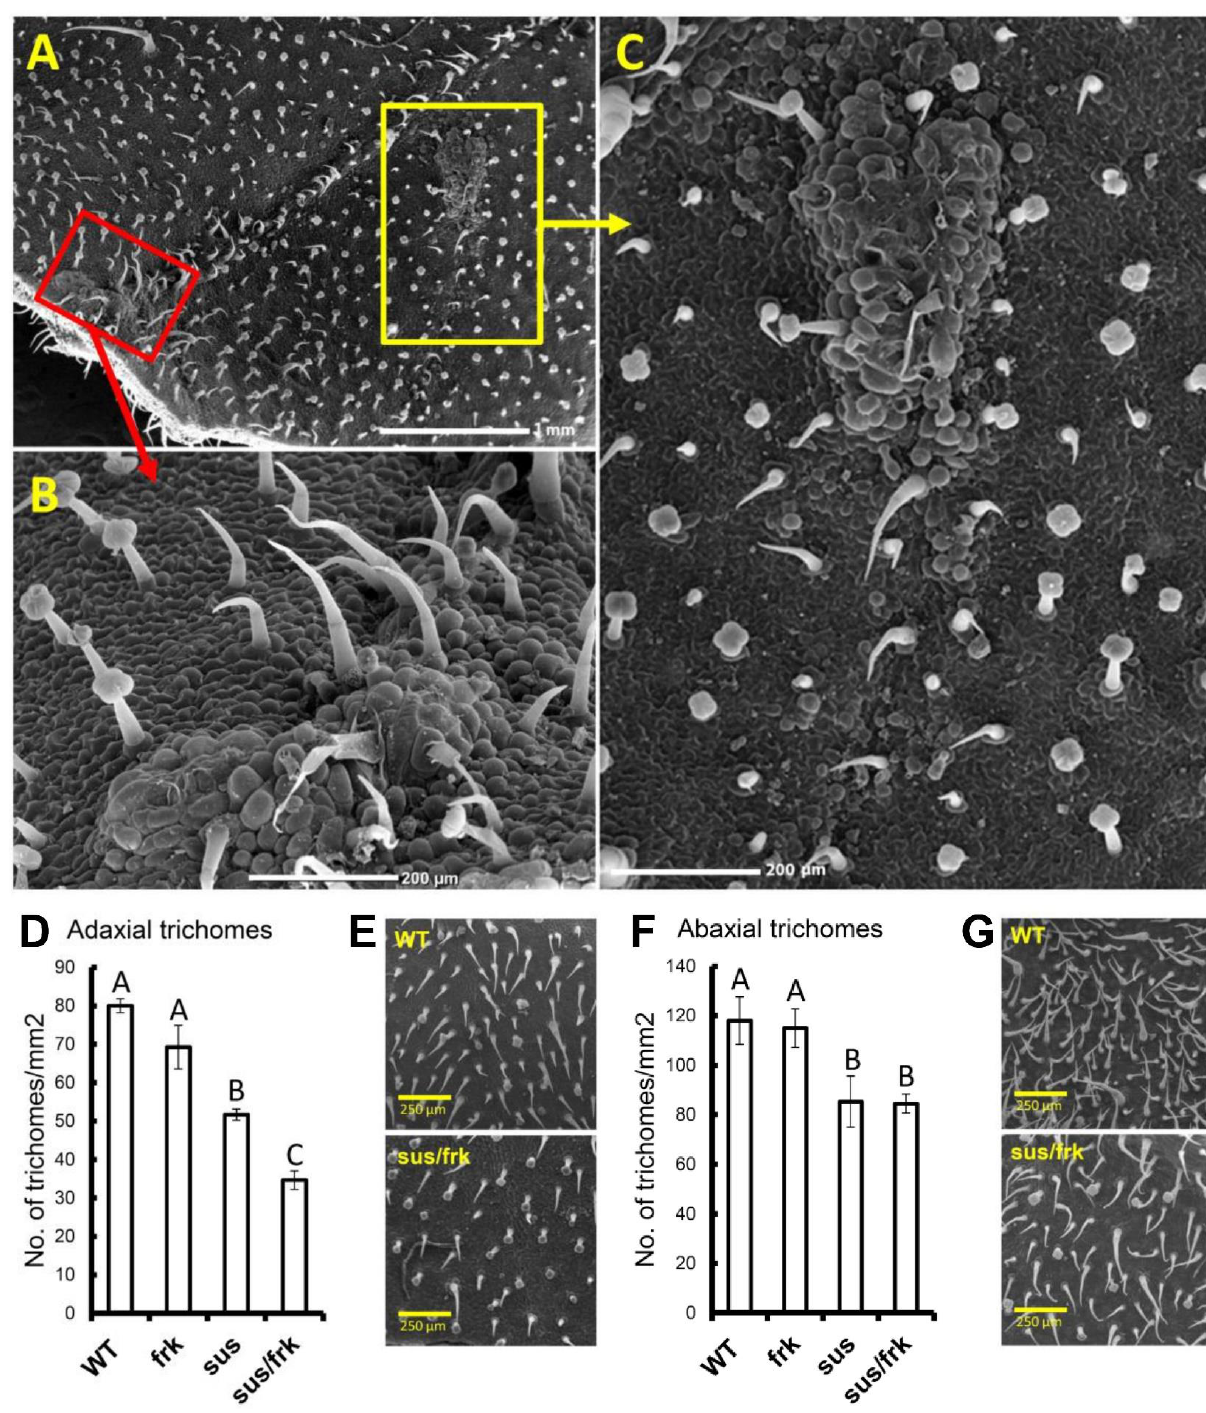
Figure 6. Formation of callus tissue on the adaxial blade of a sus / frk leaf and the sus / frk leaves showed reduced trichome density on both their adaxial and abaxial sides. ( A ) Adaxial blade of a sus / frk leaf. ( B ) Enlargement of the area indicated by the red box in ( A ). Notice the callus tissue. ( C ) Enlargement of the area indicated by the yellow box in A. The arrows point to callus formation. ( D ) Total trichome density on the adaxial side of the blade among frk , sus and sus / frk plants, compared to the WT. ( E ) SEM images of the WT and sus / frk adaxial leaf surfaces. ( F ) Total trichome density on the abaxial side of the blade in frk , sus and sus / frk plants, compared to the WT. ( G ) SEM images of WT and sus / frk abaxial leaf surfaces. Error bars indicate the standard error ( n ≥ 4). Different letters indicate a significant difference ( t -test, p <